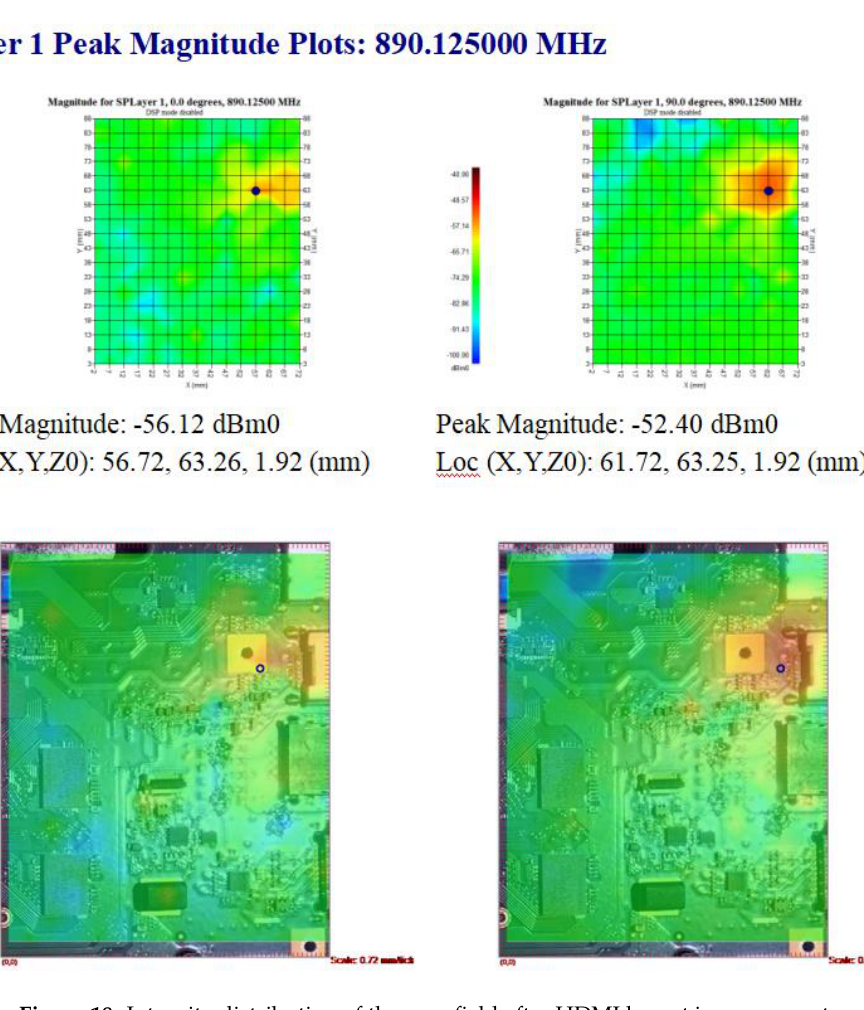
Table 2. EMI measurement data after HDMI layout improvement.